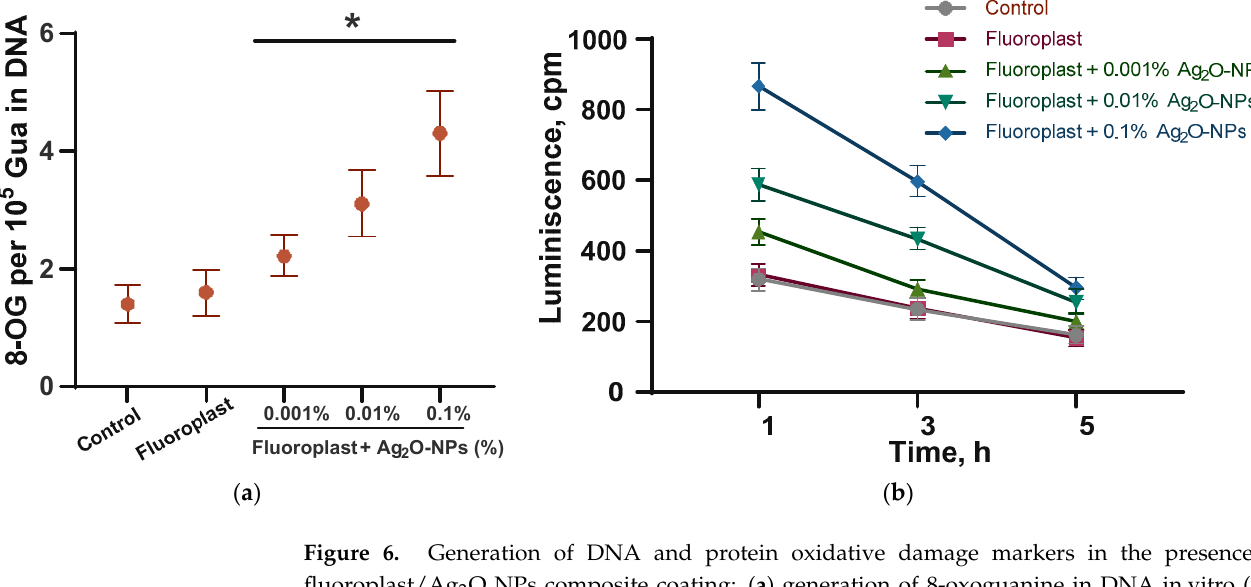
Figure 6. Generation of DNA and protein oxidative damage markers in the presence of fluoroplast/Ag 2 O NPs composite coating: ( a ) generation of 8-oxoguanine in DNA in vitro (2 h, 45 °C); ( b ) LRPS generation (2 h, 40 °C). Data are presented as mean ± SE. * p < 0.05, Mann–Whitney test ( n = 3). 8-OG-8-oxoguanine.